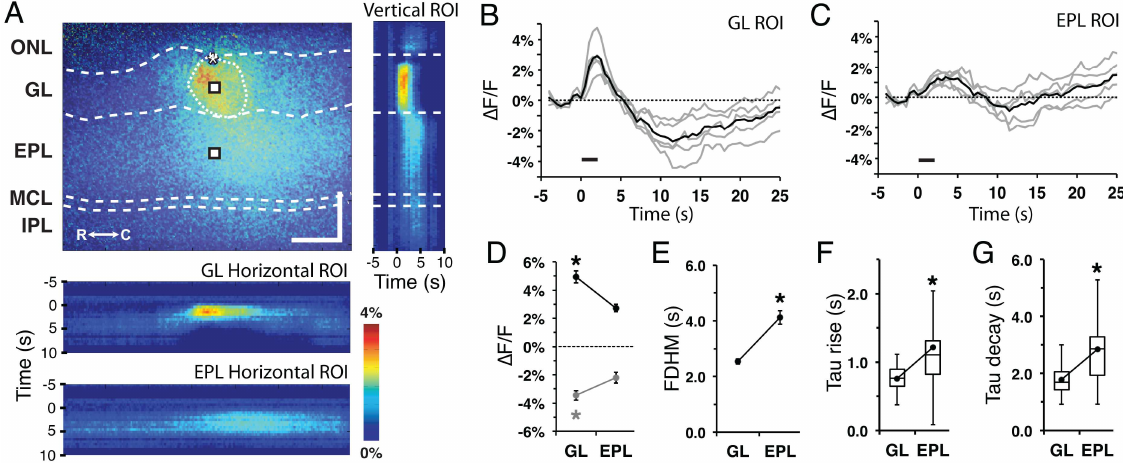
Fig 3. Flavoprotein signal profile in the glomerular and external plexiform layers. (A) (top) Flavoprotein responseat 2.5s post-stimulus initiation.ONL, olfactory nerve layer; GL, glomerular layer; EPL, external plexiformlayer; MCL, mitral cell layer; IPL, internalplexiform layer; GrL, granulecell layer; R, rostral; C, caudal.Asterisk, tip of the stimulatingelectrode. Targeted glomerulus indicatedby dashedcircle. Scale bars = 150 μ m; (right) Vertical ROI heat map across the MOB layers exhibiting translaminar stimulus-dependentspread over time; (bottom) HorizontalROI heat maps from the GL and EPL exhibitingstimulus-dependent lateral spread over time. (B and C) Representative ROI individual(gray) and mean (black) traces from the activated (B) glomerular and (C) EPL, indicatedin (A). Line: stimulus train deliveryand duration. (D) Mean signal amplitudeof the light and dark phases betweenthe GL and EPL areas. (E) Mean FDHM between the GL and EPL. (F and G) Flavoproteinsignal(F) time-to-peak and (G) time-to-trough betweenthe GL and